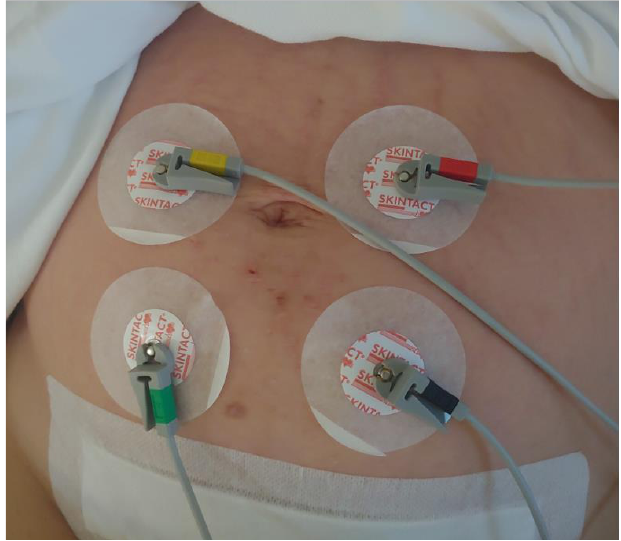
Figure 1. EHG electrode placement for recording after caesarean section — two sets of bipolar elec- trodes placed three to four centimeters apart around the navel.